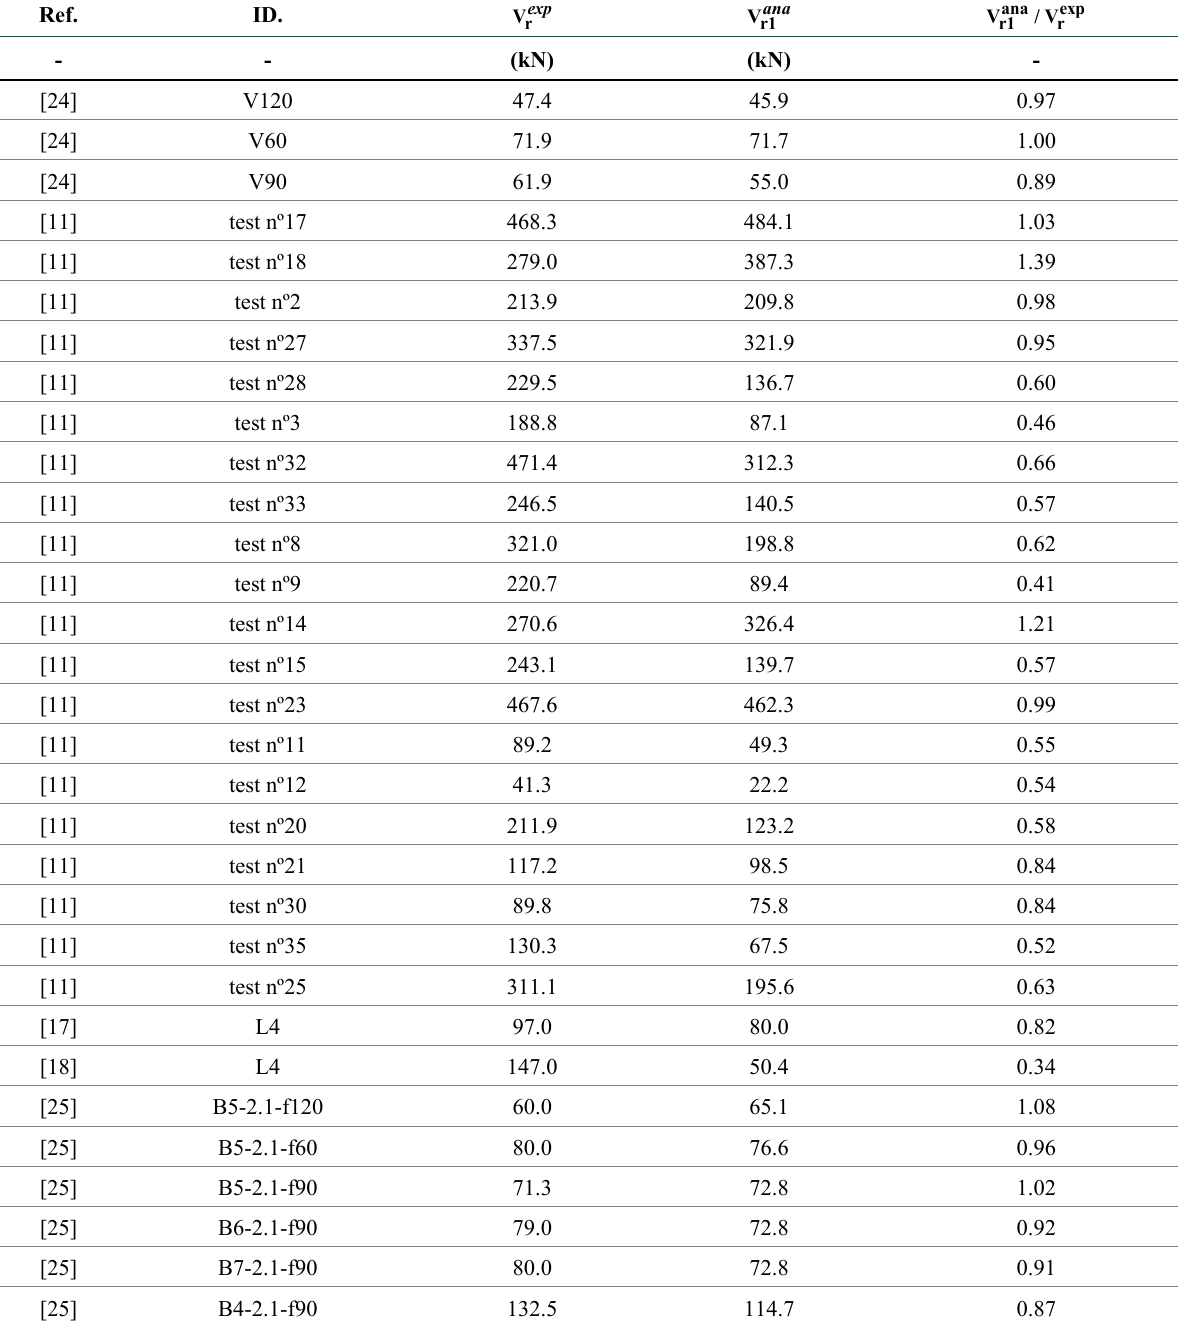
Table 5. Analytical and experimental results for shear force